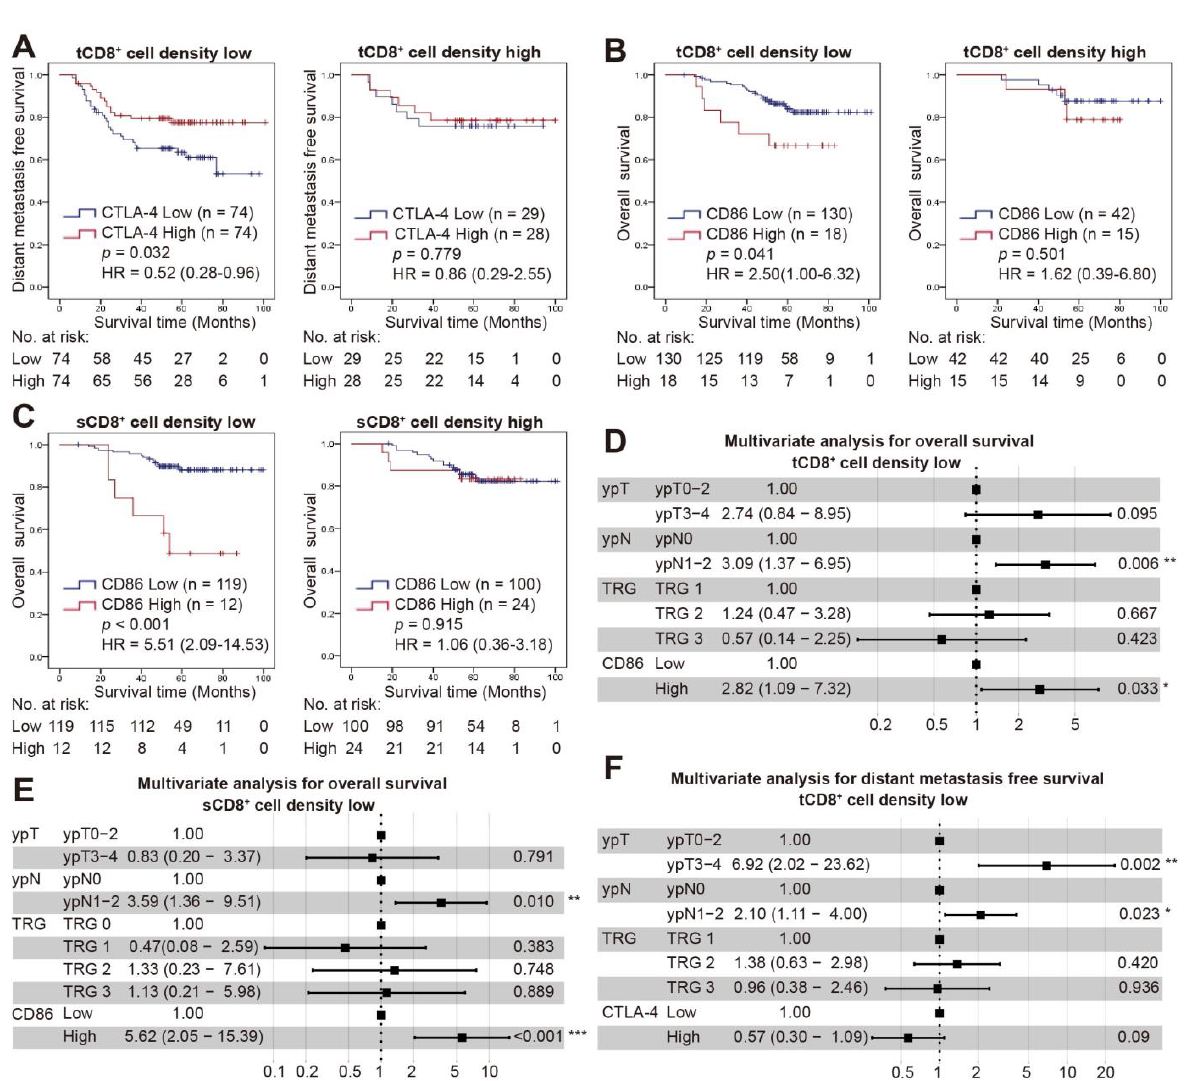
Figure 4. Combined status of CD8 + cell density and CTLA-4/CD86 expression with survival. ( A ) Kaplan-Meier curve for DMFS in low or high tCD8+ cell density groups according to CTLA-4 expression. ( B , C ) Kaplan-Meier curves for OS in low or high tCD8 + ( B )/sCD8 + ( C ) cell density groups according to the CD86 expression. ( D – F ) Forest plots of PFS and DMFS for variables by multivariate Cox analysis in low tCD8 + ( D , F )/sCD8 + ( E ) cell density groups. *, p < 0.05; **, p < 0.01; ***, p < 0.001.